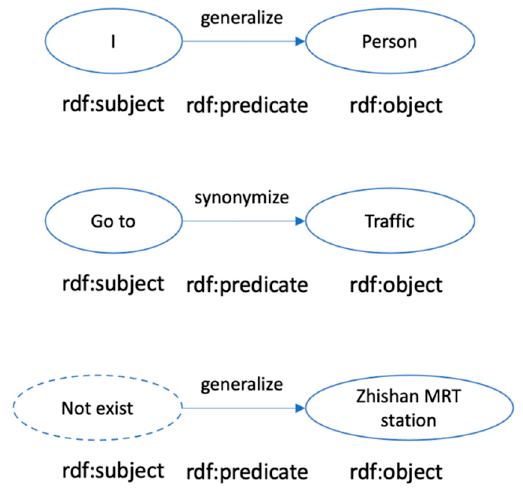
Figure 5. Concept conversion via knowledge graph.